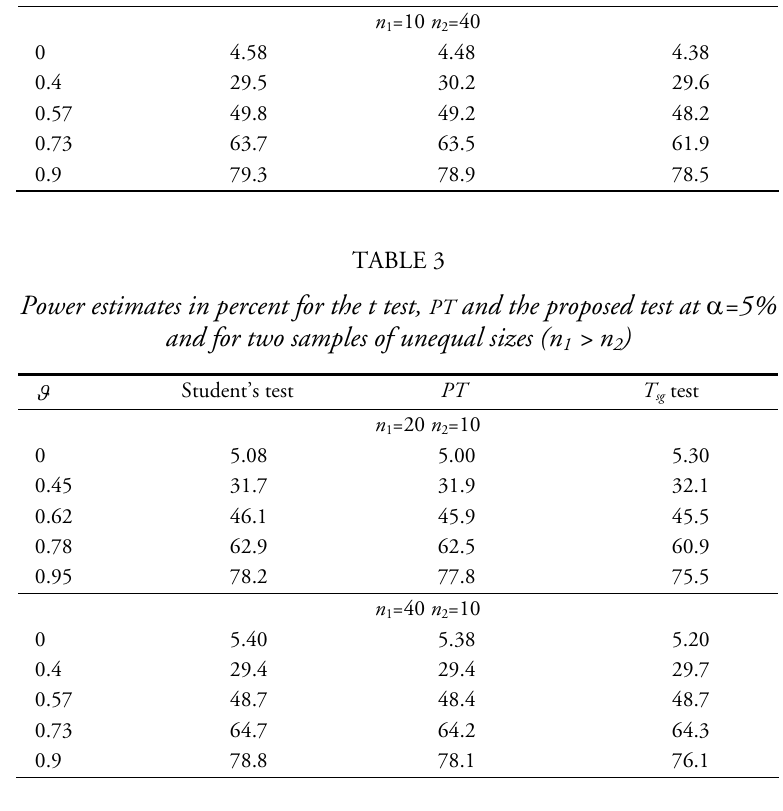
Power estimates in percent for the t test, PT and the proposed test at (cid:68) =5% and for two samples of unequal sizes (n